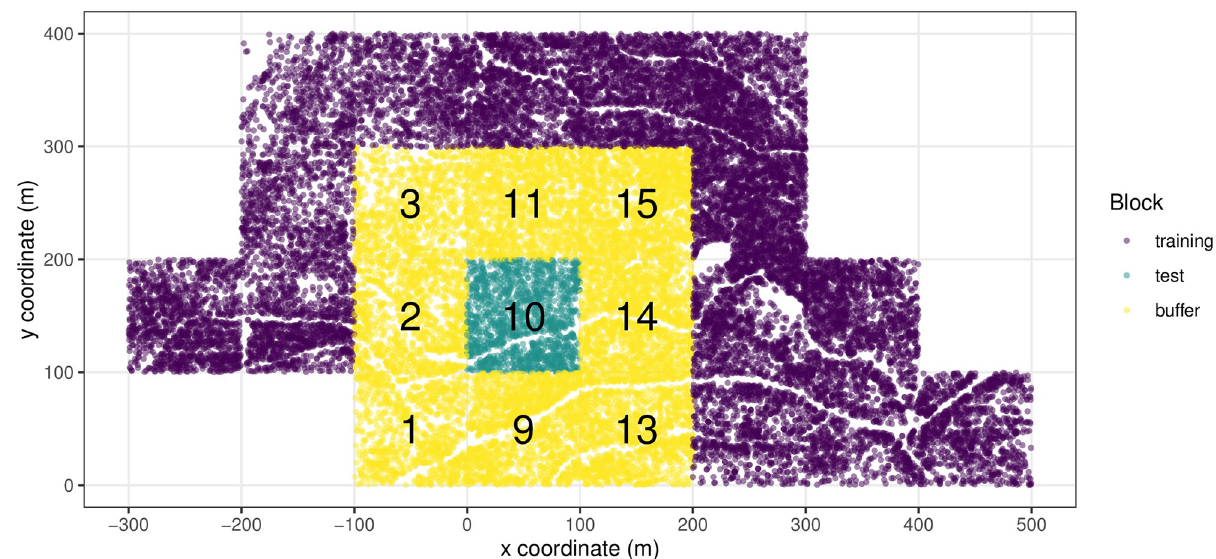
Fig 1. Big Woods study region with one iteration of spatial cross-validation algorithm displayed. For this particular iteration of the cross-validation algorithm, we train our models on all 14 unnumbered blocks of trees. We then apply the fitted model to make predictions on block 10. Blocks 1, 2, 3, 9, 11, 13, 14, and 15 act as “buffer” blocks isolating the test block from the training blocks.